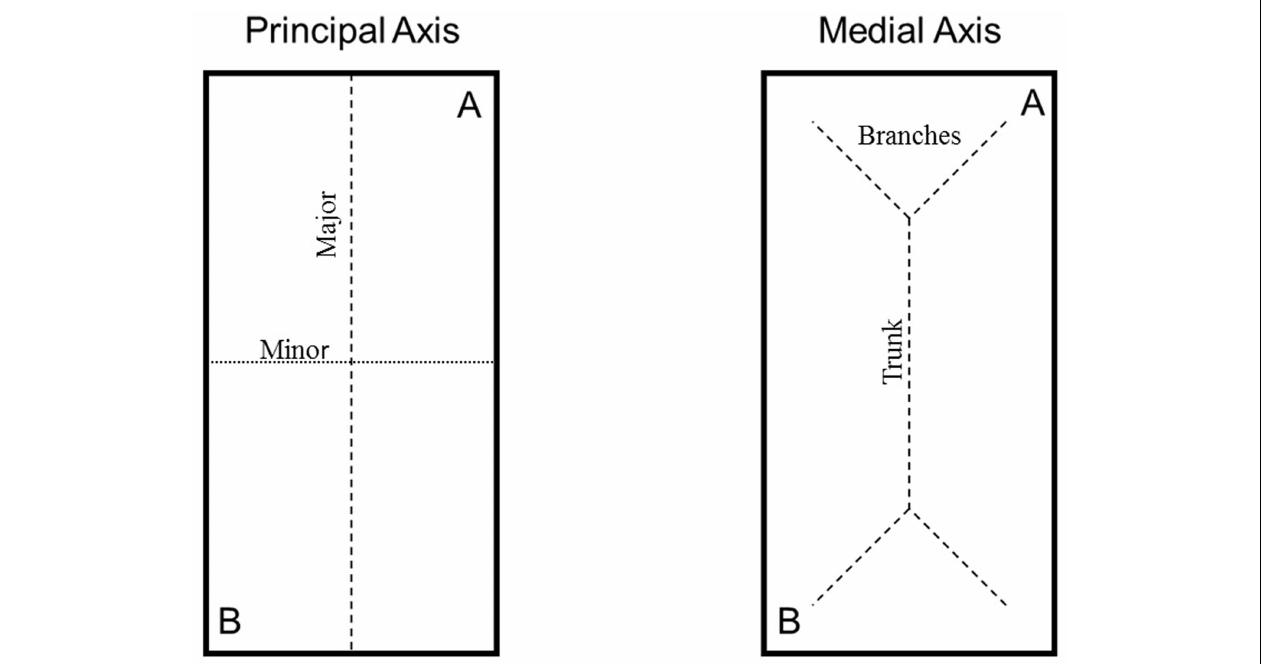
FIGURE 1 | Illustration of principal-axis-based (left panel) and medial-axis-based (right panel) strategies. A represents trained location, and B represents the rotationally equivalent